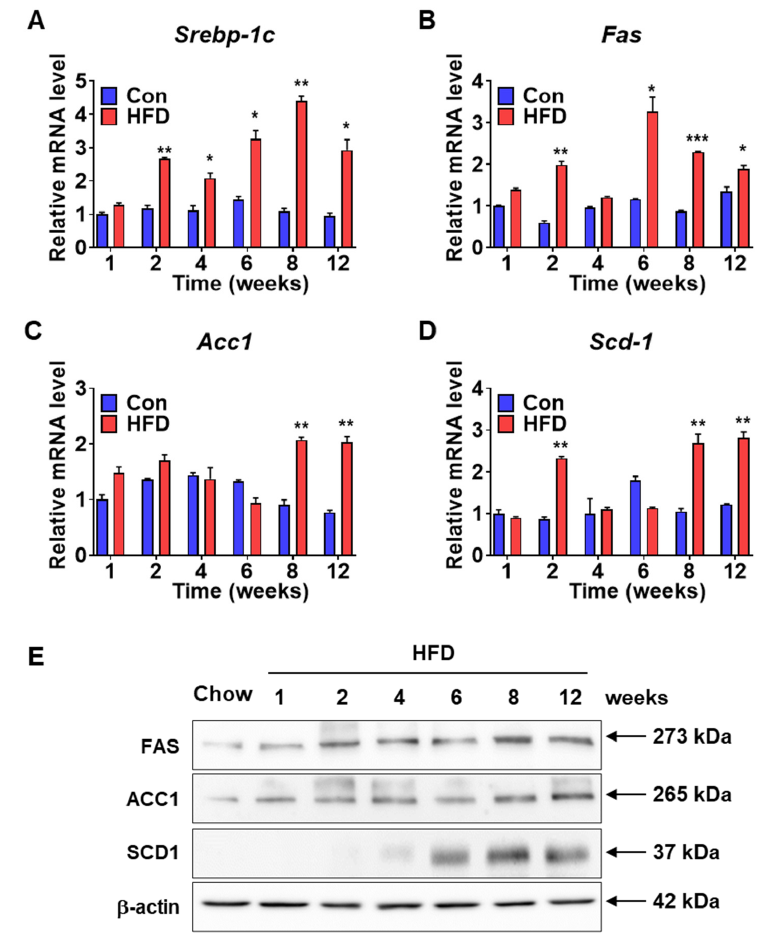
Biomedicines 2022 , 10 , 72 10 of 17 Figure 4. Lipogenic gene expression in the livers of control and HFD-fed WT mice: ( A – D ) Expression levels of lipogenesis marker genes (Srebp-1c, Fas, Acc1, and Scd1) in the liver were assessed by qPCR ( n = 5). ( E ) Western blot data of FAS, ACC1, and SCD1 from the livers of WT mice when on chow diet and HFD ( n = 5). * p < 0.05, ** p < 0.01 and *** p < 0.001 control vs. HFD-fed WT mice at the respective weeks. Srebp-1c: sterol-regulatory-element-binding protein-1c, Fas: fatty acid synthase, Acc1: acetyl-CoA Carboxylase 1, Scd1: stearoyl-CoA desaturase-1. 3.5. Inflammatory Gene Expression in Pre-DM and DM